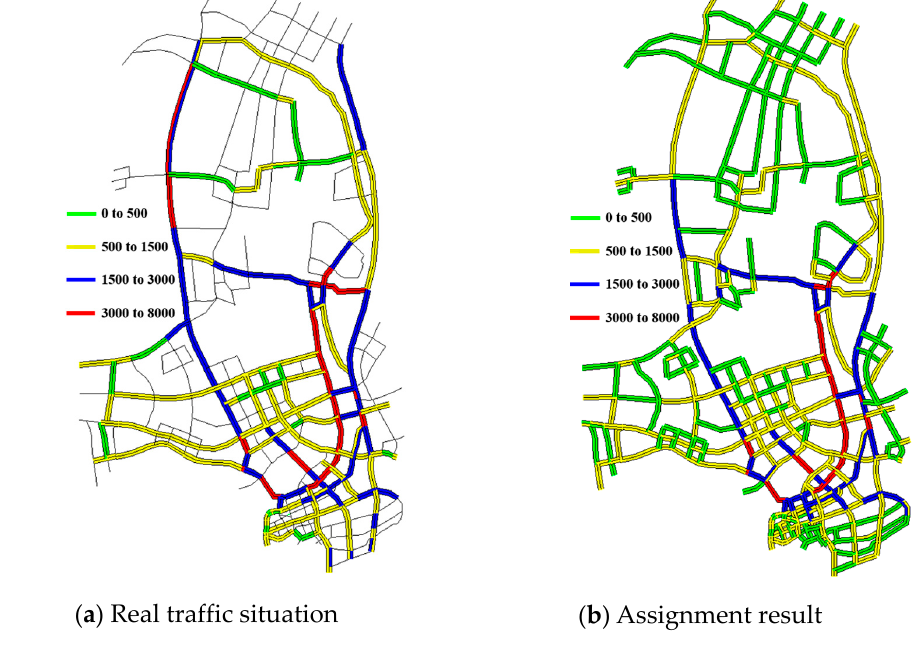
Figure 3. Traffic volume of private cars. Figure 3. Tra ffi c volume of private